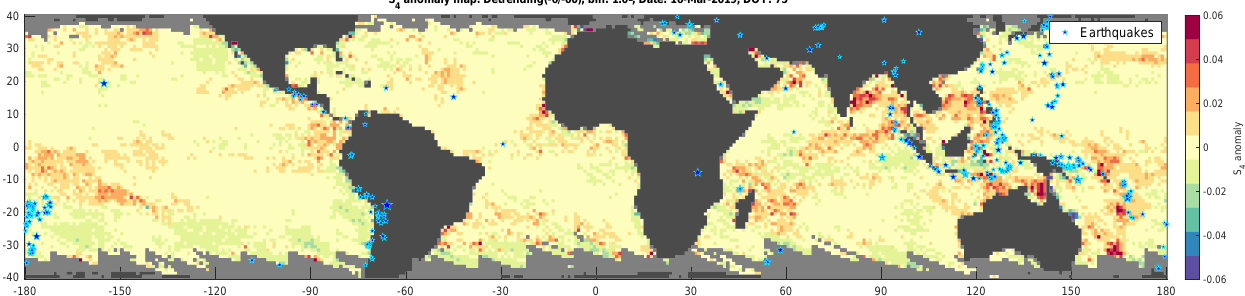
Figure 8. S 4 variations map computed from the seven days prior to 16 March 2019, after subtracting the preceding 60 day average over all oceanic regions between 40ºS and 40ºN latitudes. Blue stars indicate the earthquakes’ epicenters happening from six days before to six days after. The image shows the results of the detrended ∆ S 4 values for the selected day over oceanic regions with the values ranging from − 0.06 to 0.06 as indicated in the color scale. Blue stars mark the epicenter of all earthquakes happening during the period from − 6 days to +6 days from the current day 16 March.